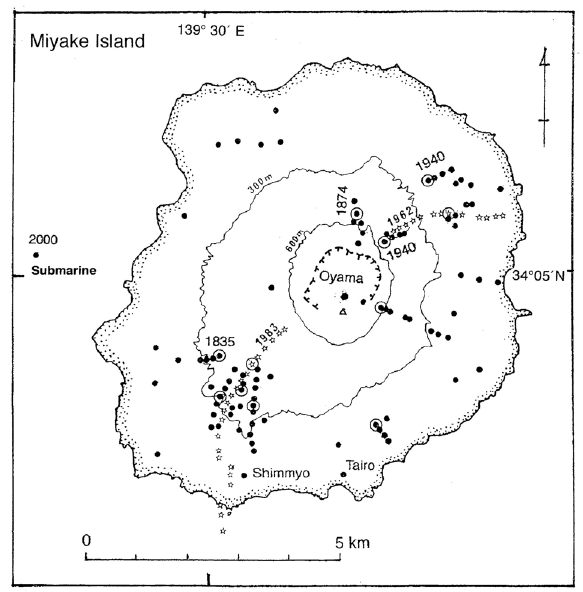
Figure 5. Distribution of parasitic vents on Miyake Island mainly according to Isshiki [1960], including the vents of the 1962 and 1983 eruptions. Chains of vents are assigned by the present author and double circles denote the first eruption vents of the chains. “Shim- myo” and “Tairo” in the south are prehistoric crater lakes. The sum- mit topography is as of 1991.